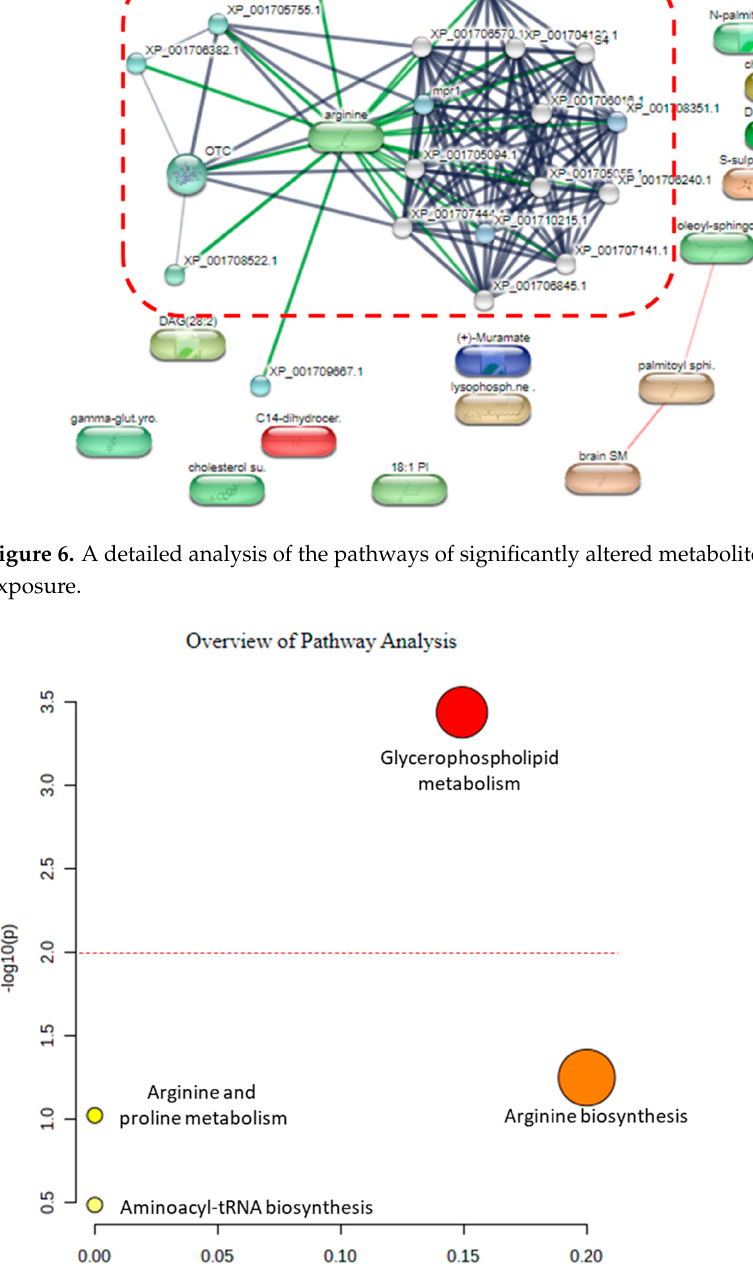
Figure 7. Metabolite annotation and pathway analyses using MetaboAnalyst.